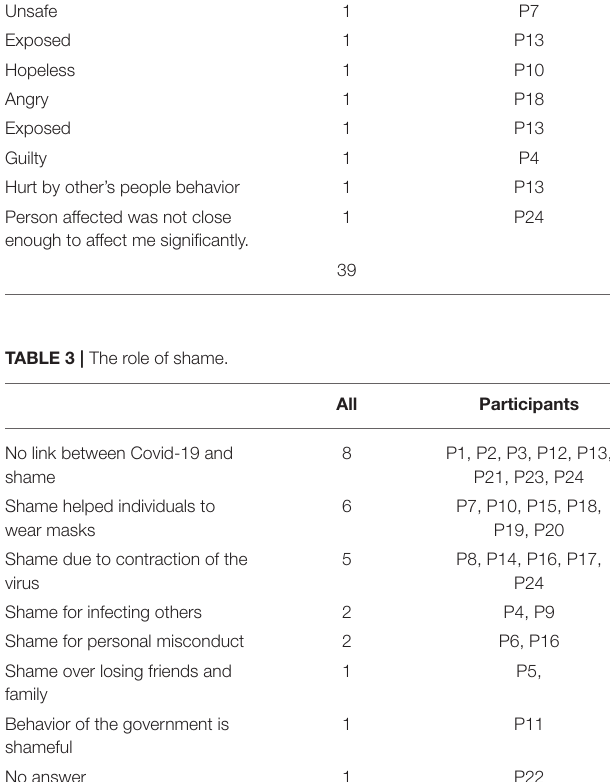
TABLE 5 | The societal impact on Covid-19 experiences.